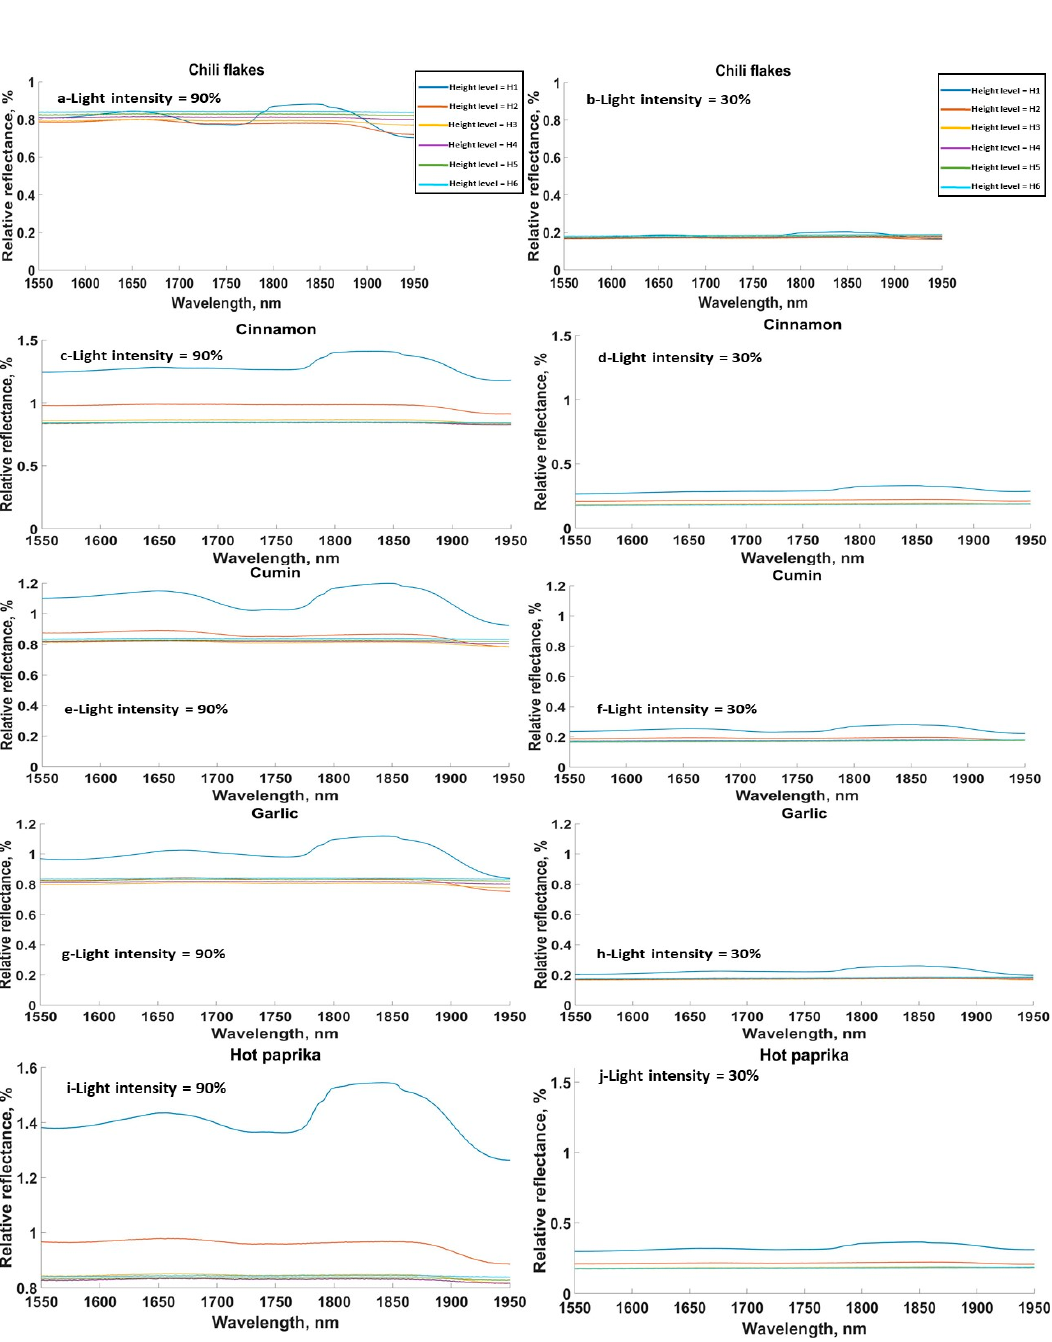
Figure 5. Relative reflectance for all light intensities and the minimum and maximum height levels, H1 and H6, for ( a , b ) chili flakes, ( c , d ) cinnamon, ( e , f ) cumin, ( g , h ) garlic granules, ( i , j ) hot paprika.